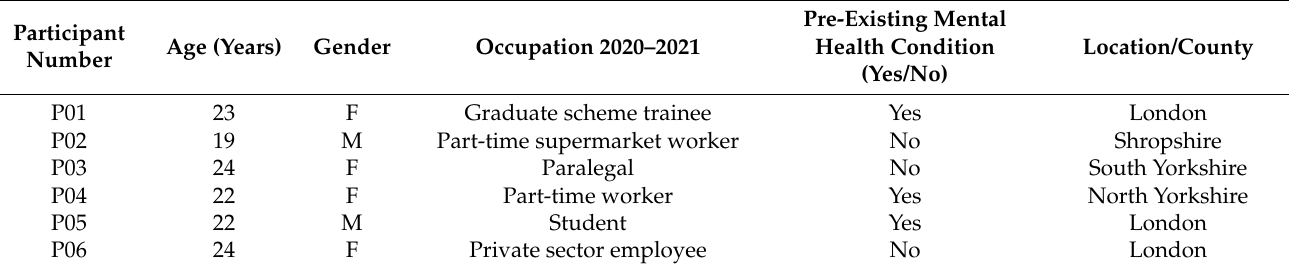
Table 1. Participant